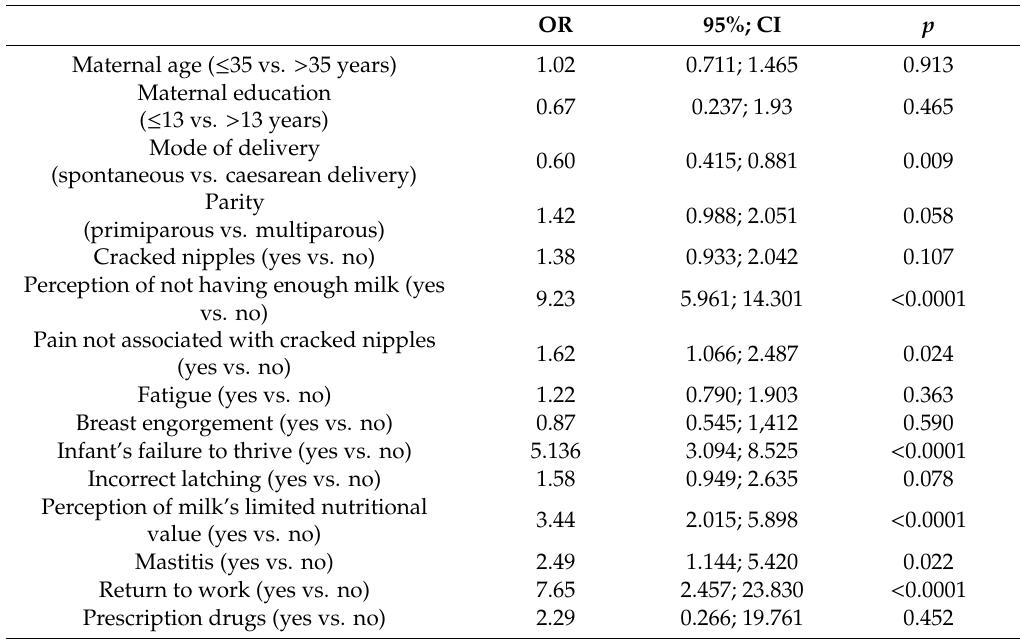
Table 4. Association among maternal age and education, the mode of delivery, parity, and types of breastfeeding di ffi culties and the mode of infant’s feeding at three months (univariate binary logistic regression